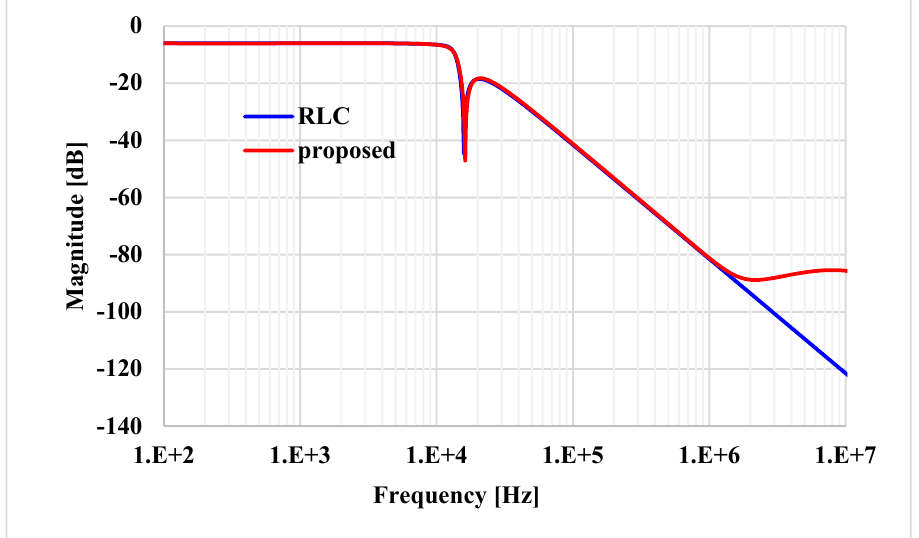
Electronics 2021 , 10 , x FOR PEER REVIEW Figure 27. The frequency responses of the LP ladder filter based on VD-DIBA and RLC.